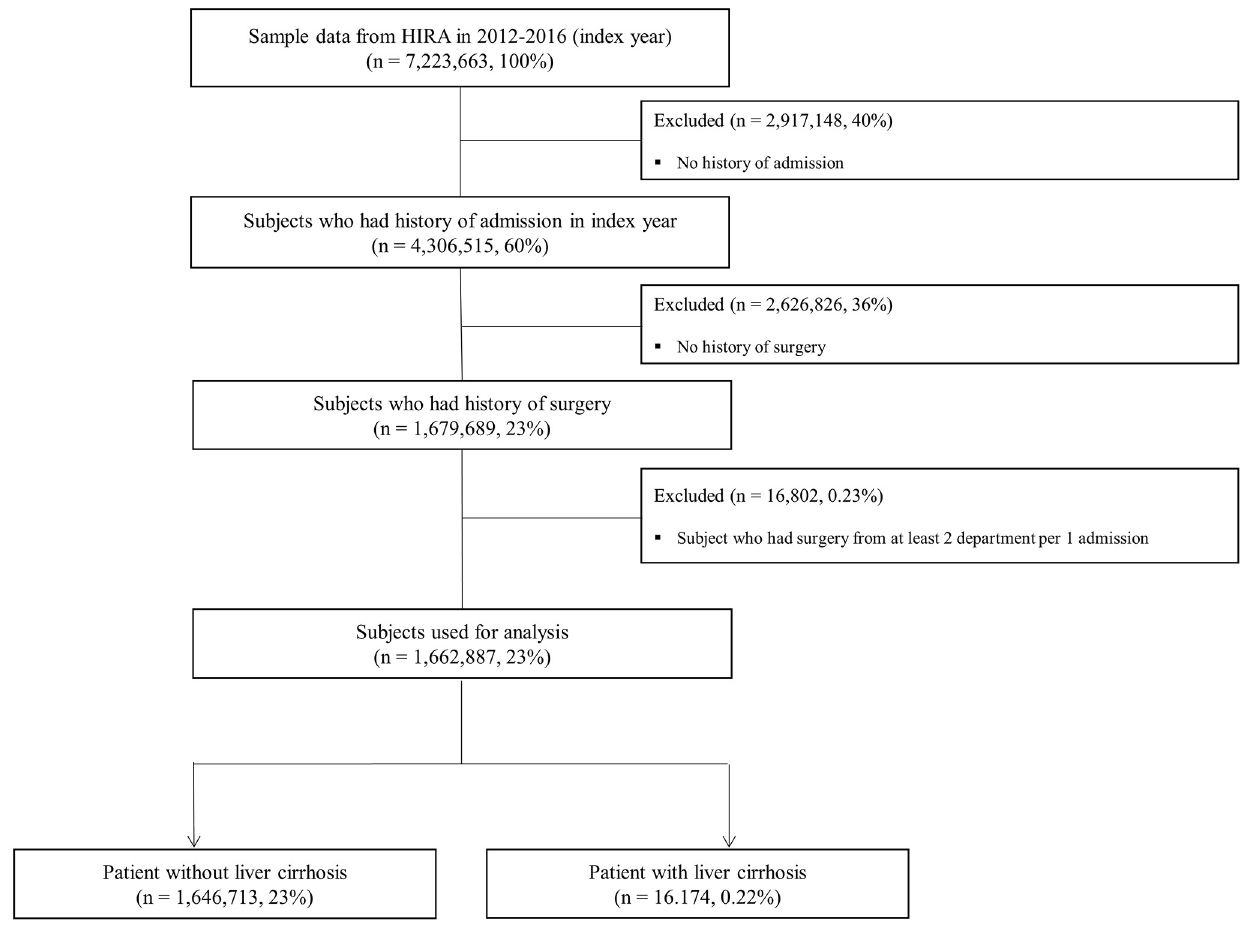
Fig 1. Flow chart of study sample